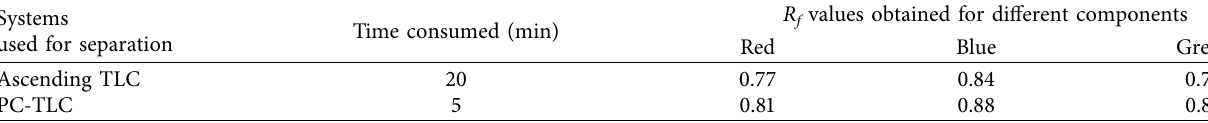
Table 2: Separation of fountain pen ink by classical and pressurized TLC.